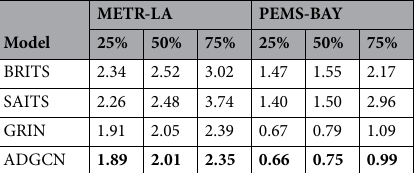
Table 4. Comparison of model MAE results when data absence rate increases. The best results are in